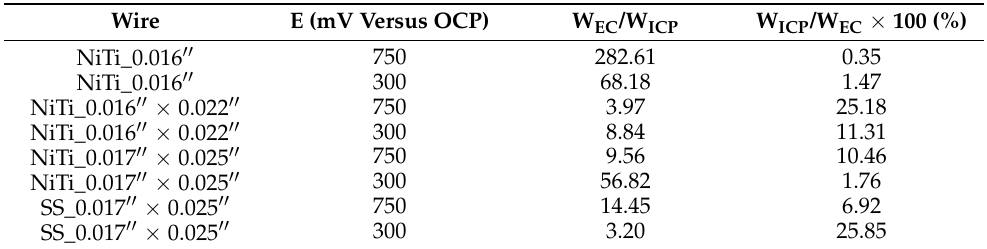
Table 14. The relation between the expected ion release from the potentiostatic measurements and the metal ions released as calculated from the ICP-MS analysis.